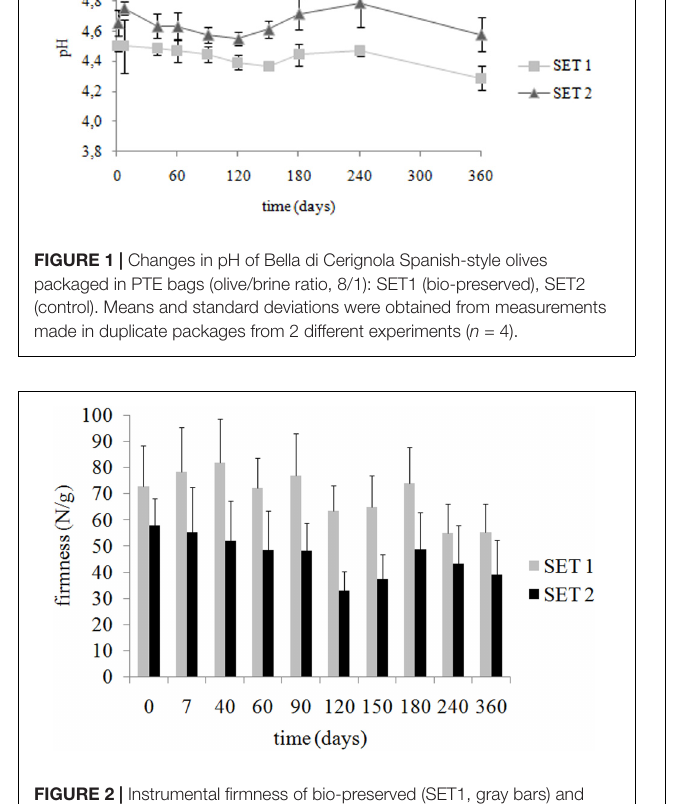
FIGURE 3 | Evolution of color parameters Luminance L ∗ (A) , green-red a ∗ (B) and blue-yellow b ∗ (C) in SET1 (bio-preserved), and SET2 (control) Bella di Cerignola Spanish-style olives packaged in PTE bags (olive/brine ratio, 8/1). Means and standard deviations were obtained from measurements made on nine different olives analyzed in duplicate packages per each experiment ( n =